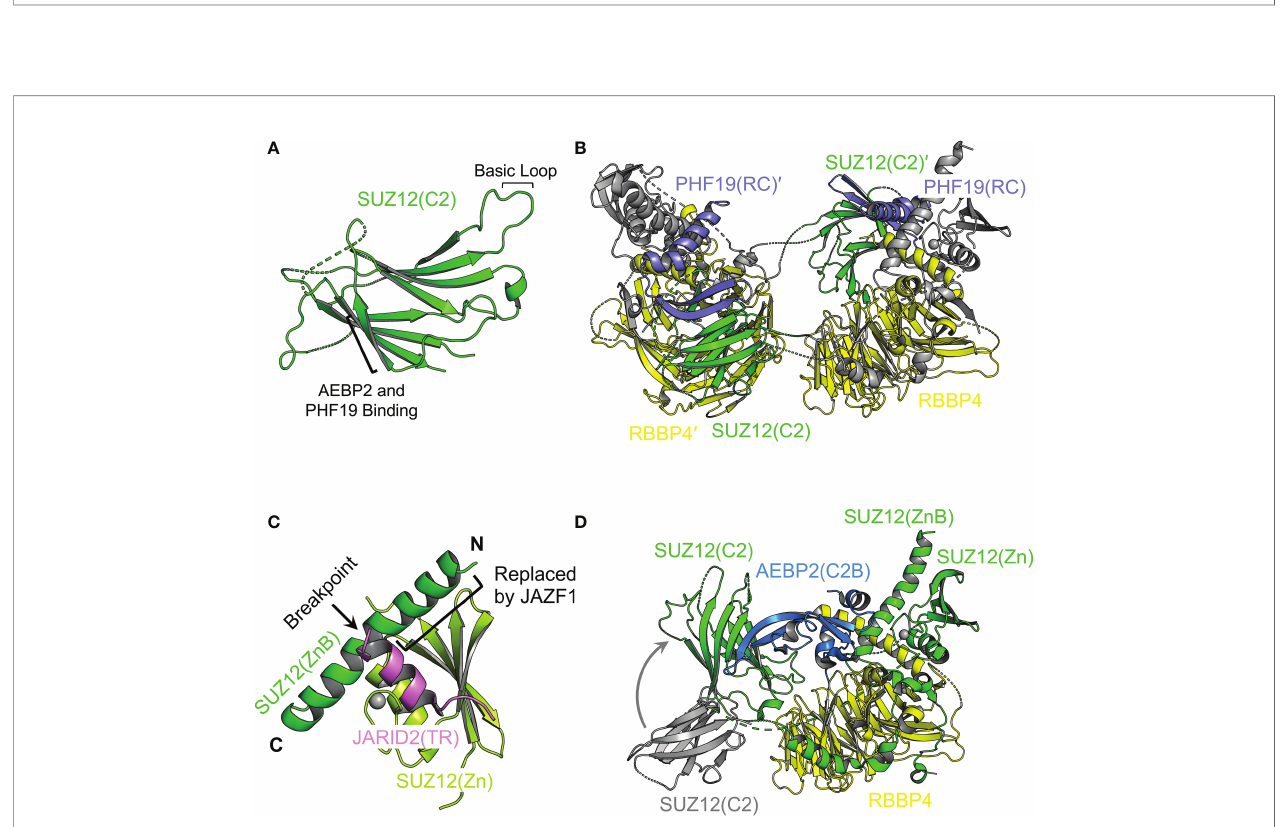
FIGURE 5 | Structural dissection of the complex assembly of the accessory subunit-binding module Structural features of the accessory subunit-binding module are highlighted. (A) Structure of the SUZ12(C2) domain (from PDB 5WAI). The basic loop for RBBP4 binding and b strand for ABEP2 and PHF19 binding are indicated. (B) Structure of the SUZ12(N) – RBBP4 dimer stabilized by the PHF19(RC) domain (from PDB 6NQ3). SUZ12 is colored in gray except for the C2 domain, which is swapped between two protomers and shown in green. Domains and subunits from two protomers are distinguished by the prime symbol. (C) Structure of AEBP2 bound to SUZ12(N) – RBBP4 (from PDB 5WAI). The C2 domain from the dimeric structure is shown in gray. Structural transition of the C2 domain accompanied by AEBP2 binding and dimer disruption is indicated by a curved gray arrow. The JARID2(TR) is omitted for clarity. (D) Structure of JARID2(TR) bound to the intramolecular complex of SUZ12(ZnB) and SUZ12(Zn) (from PDB 5WAI). The breakpoint of SUZ12(ZnB) in oncogenic chromosomal translocation is indicated by a black arrow. The black bracket indicates the part of the SUZ12(ZnB) helix replaced by JAZF1.